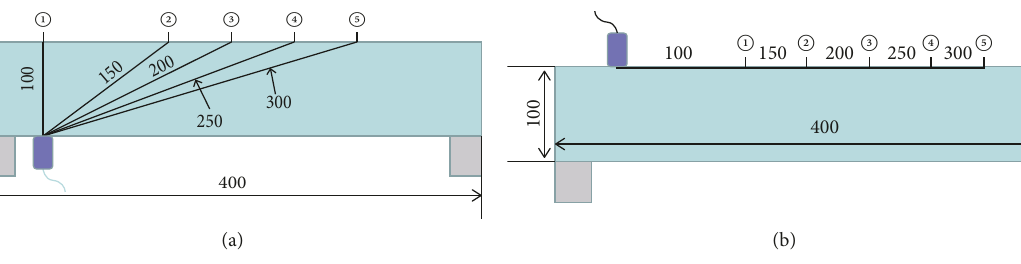
Figure 6: Schematic diagram of pencil lead fracture position. (a) Perpendicular. (b) Parallel (distance unit: mm).